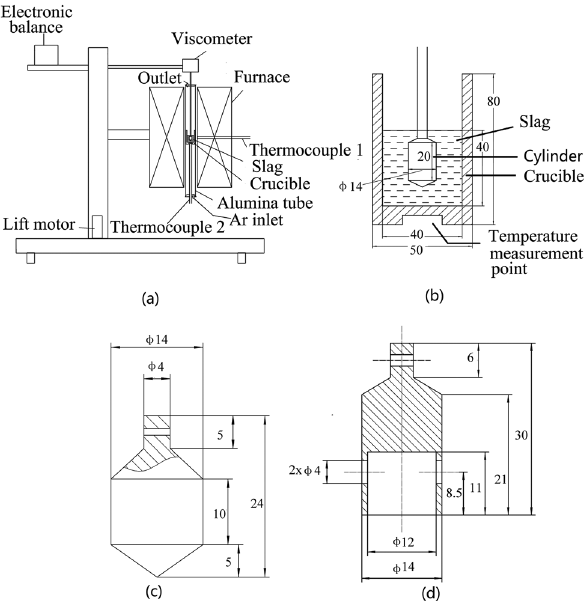
Figure 1: Schematic fi gure of experimental equipment: ( a ) type RTW - 10 experimental apparatus for melts physical properties measure - ment; ( b ) crucible and cylinder used for the viscosity measurement; ( c ) molybdenum bob used for the density measurement; and ( d ) molybdenum ring used for the viscosity